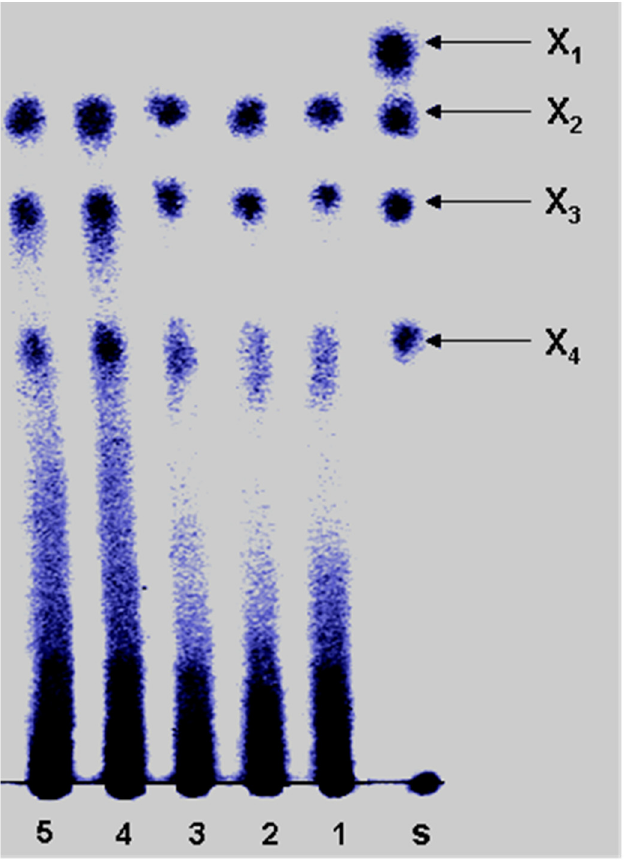
Figure 6. TLC study of birchwood xylan hydrolysis products produced by B. paramycoides xy- lanase.Lane S: a mixture of xylose (X 1 ), xylobiose (X 2 ), xylotriose (X 3 ), and xylotetraose (X 4 ); Lane 1: birchwood xylan hydrolysate (for 1 h); Lane 2: for 2 h; Lane 3: 3 h; Lane 4: for 12 h; Lane 5: 24 h.